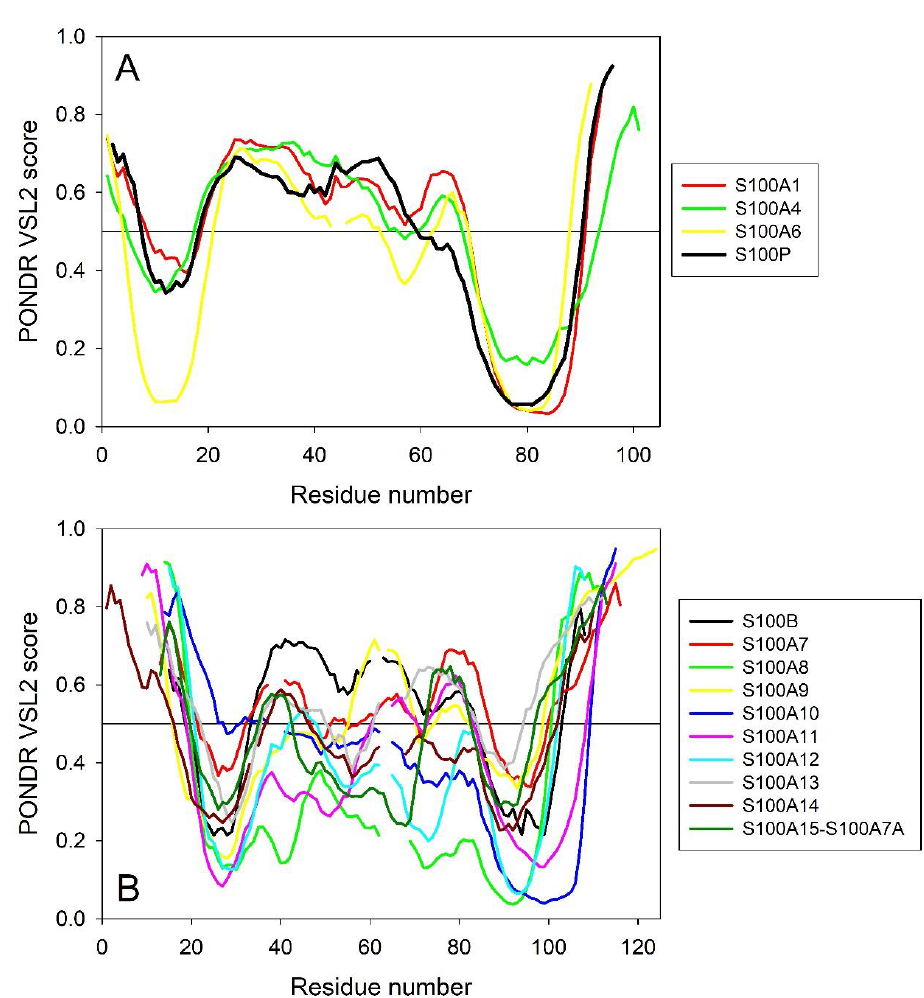
Figure 7. Intrinsic disorder predisposition of human S100 proteins capable of IFN- β binding ( A ) and non-binders ( B ) evaluated by the PONDR ® VSL2 algorithm. Plot represents data for the sequences aligned using Clustal Omega. Breaks in the lines corresponds to the alignment gaps.